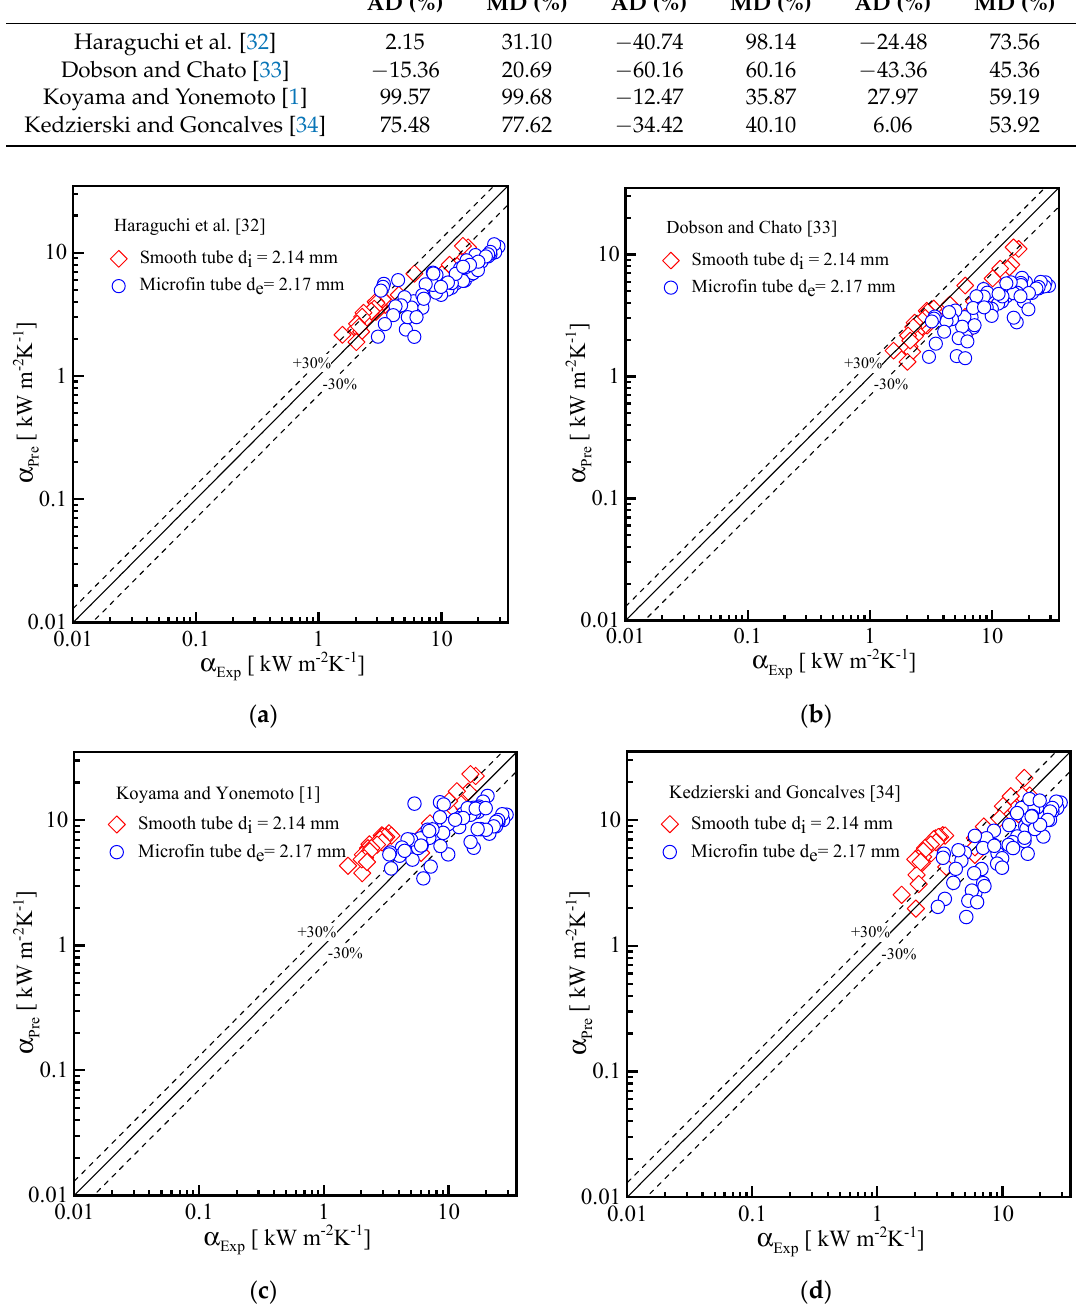
Figure 15. Comparison between the experimental and predicted condensation heat transfer coefficients using correlations: ( a ) Haraguchi et al. [32]; ( b ) Dobson and Chato [33]; ( c ) Koyama and Yonemoto [1]; and ( d ) Kedzierski and Goncalves [34].